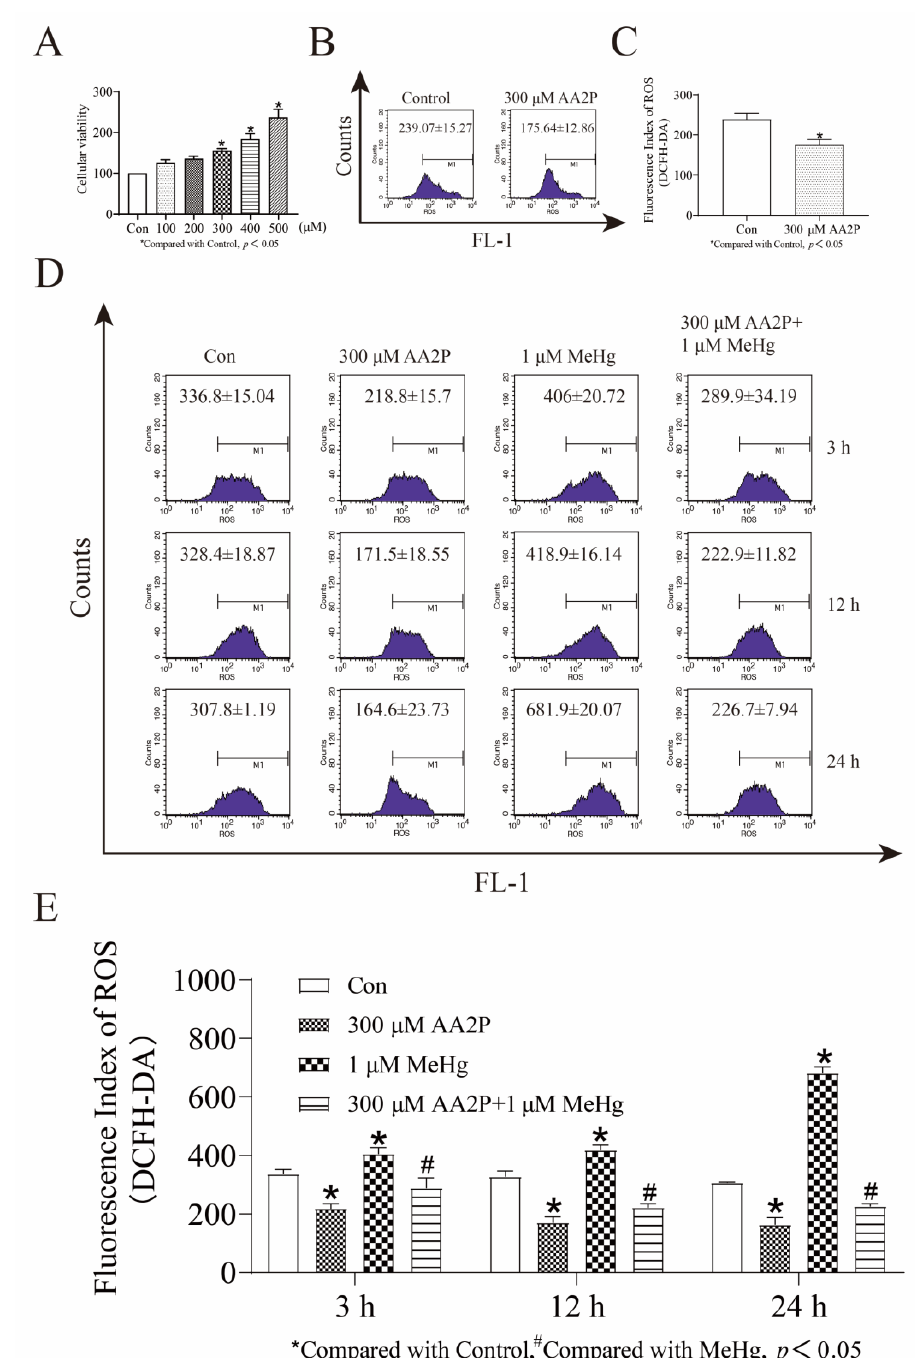
Figure 4. AA2P treatment increases the viability of SH-SY5Y cells and decreases intrinsic ROS levels and MeHg-induced ROS accumulation. ( A ) MTT assay for cell viability of 0 –500 μM AA2P. ( B ) Flow cytometry detection of ROS levels in 300 μM AA2P -treated SH-SY5Y cells for 24 h. ( C ) GraphPad Prism 8.0.2 software analysis of ROS levels in 300 μM AA2P -treated SH-SY5Y cells for 24 h. ( D ) Flow cytometry detection of ROS levels in 300 μM AA2P - and 1 μM MeHg -co-treated SH-SY5Y cells for 3, 12, and 24 h. ( E ) GraphPad Prism 8.0.2 software analysis of ROS level in 300 μM AA2P - and 1 μM MeHg - co-treated SH-SY5Y cells for 3, 12, and 24 h. The mean was calculated using GraphPad Prism 8.0.2 software. The data shown represent the mean from one of three independent experiments. Statistical significance was determined using ANOVA. Abbreviations: AA2P, L-ascorbic acid-2-phosphate sodium